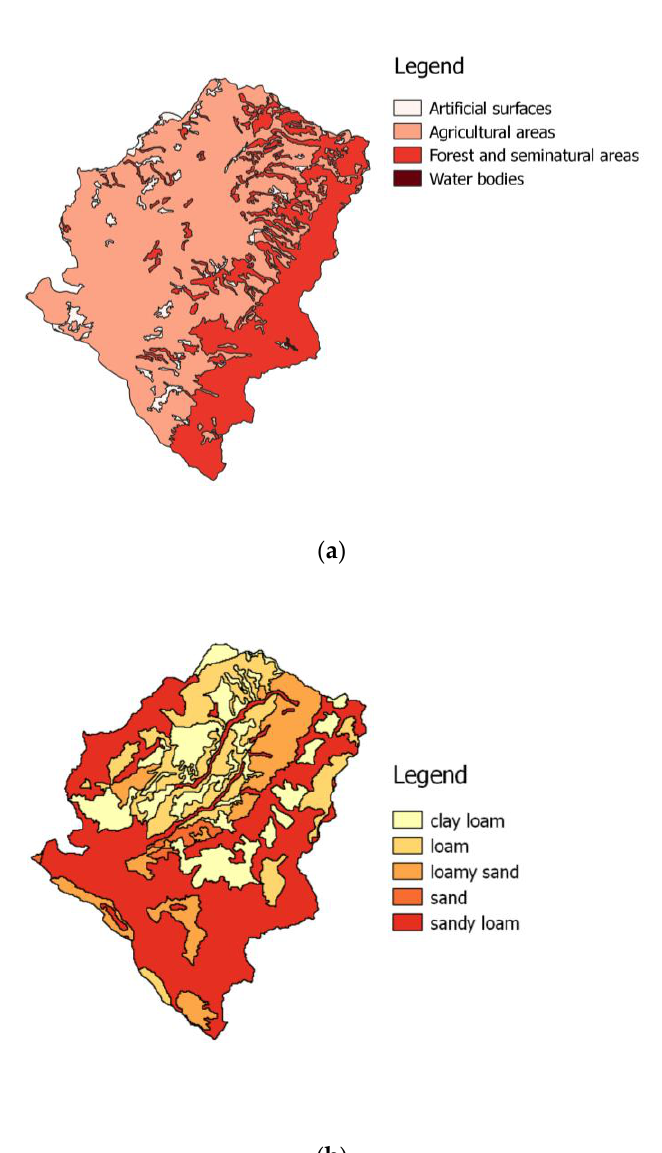
Figure 2. ( a ) Maps of land use (from Corine Land Cover, 2007) and ( b ) texture (ARSSA Calabria–Regional Agency for Development and Services in Agriculture, 2003) of the Mesima torrent (Calabria, Southern Italy).